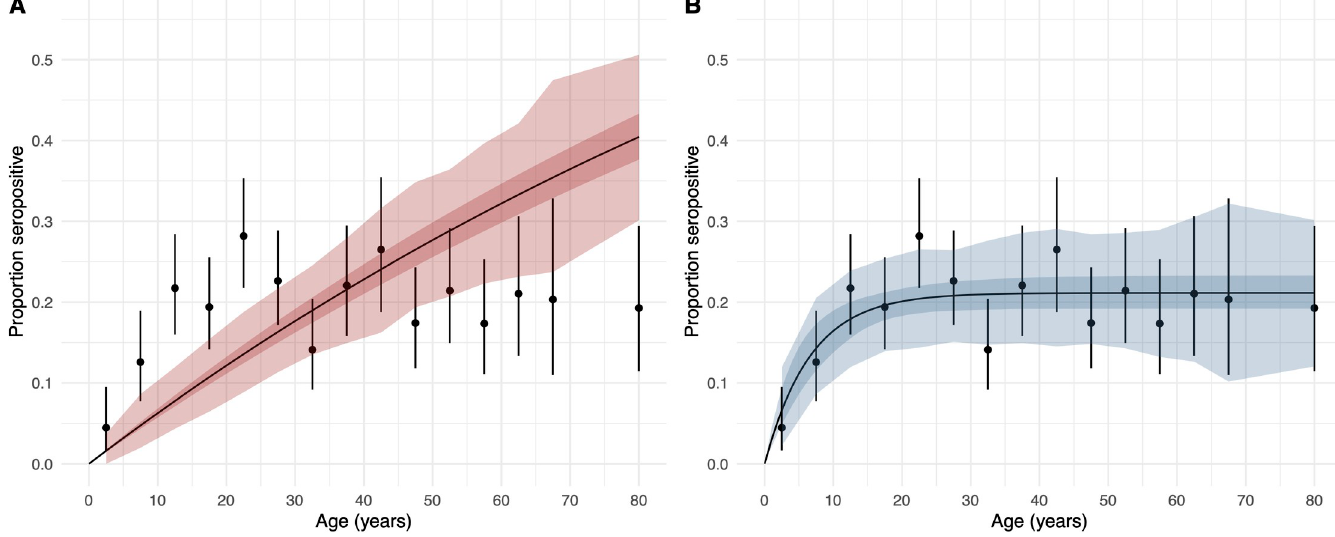
Fig 3. Proportion of seropositive individuals by age (black points represent the mean and the error bars represent the binomial 95% confidence intervals), from national serosurvey conducted in Fiji in 2013 (n = 2,152). Results from the catalytic model is shown in red (A) and reverse catalytic model is shown in blue (B), including model 95% credible intervals (darker shading) and the sampling uncertainty (binomial, lighter shading).